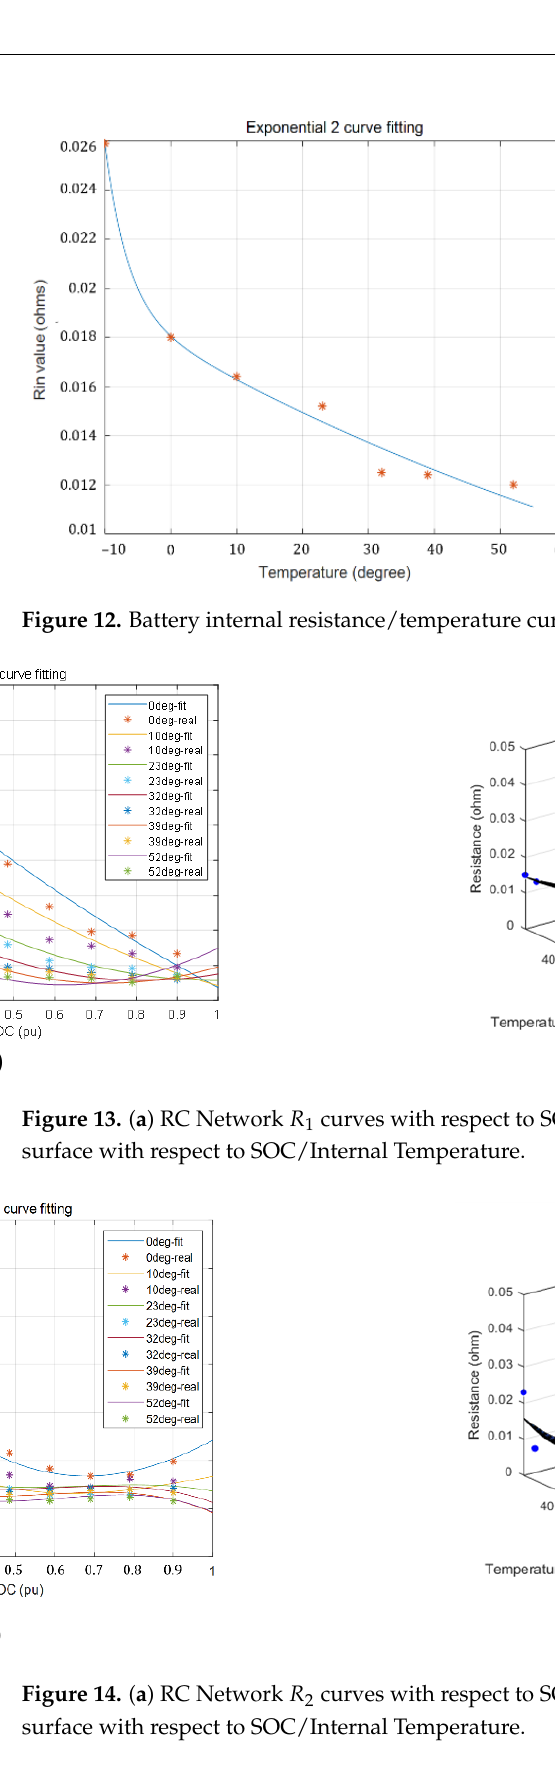
Figure 14. ( a ) RC Network 𝑅 𝑅 surface with respect to SOC/Internal Temperature. (cid:2870) Table 7. Setting parameters for the Q-learning agent and training options. Q-learning Agent Options